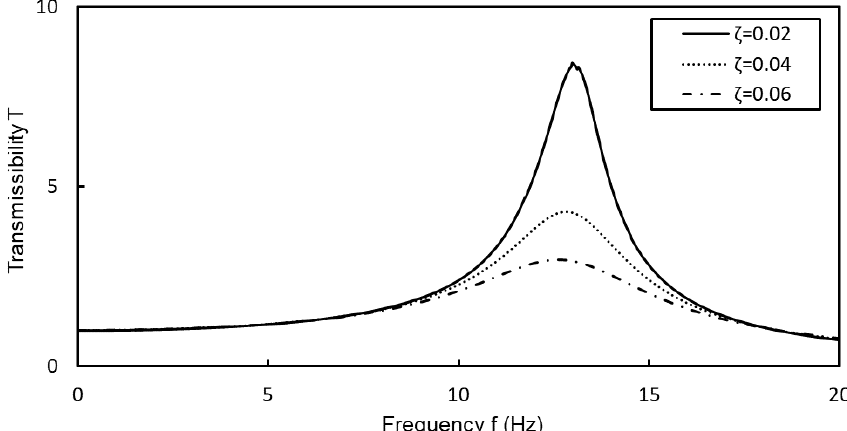
Figure 12. Transmissibility of the non-linear stiffness isolator module of VEAM with varying values of ζ.